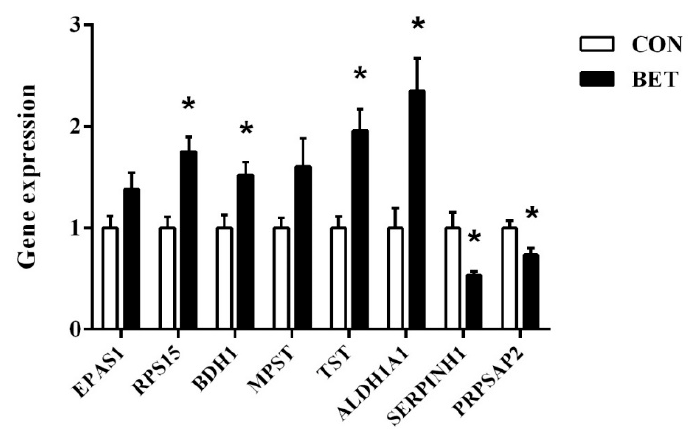
Figure 3. Verified the selected eight DAPs by real-time PCR. CON—control group; BET—betaine group; EPAS1—endothelial PAS domain protein 1; RPS15—ribosomal protein S15; BDH1—3-hydroxybutyrate dehydrogenase 1; MPST—mercaptopyruvate sulfurtransferase; TST—thiosulfate sulfurtransferase; ALDH1A1—aldehyde dehydrogenase 1 family member A1; SERPINH1—serpin family H member 1; PRPSAP2—phosphoribosyl-pyrophosphate-synthetase-associated protein 2.